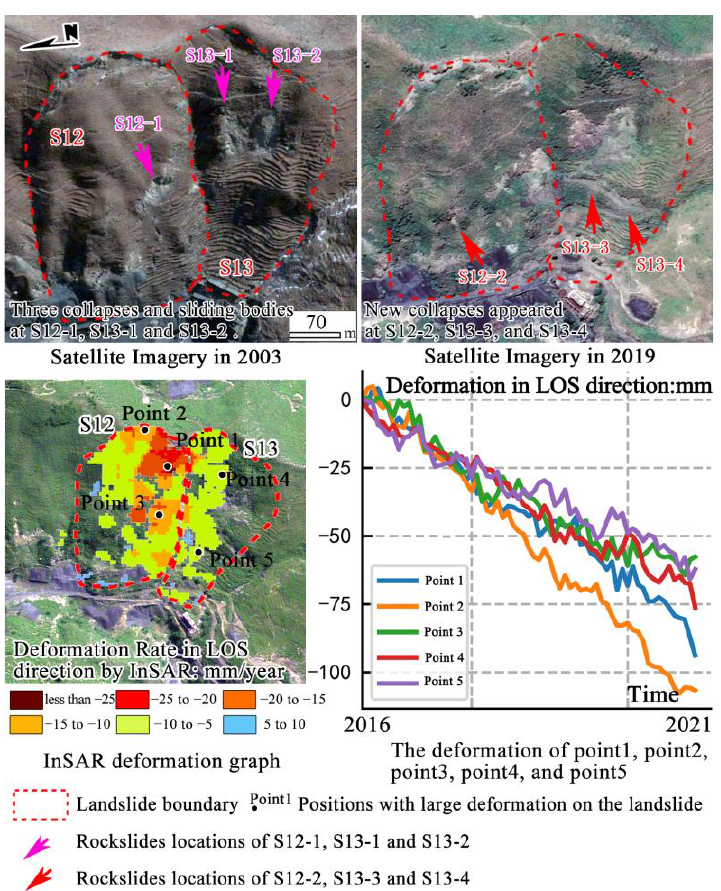
Figure 9. Optical images of landslide S12 and S13 acquired in 2003, and 2019 (the upper two panels). Deformation velocity of landslide S12 and S13 got by InSAR (left lower panel). The deformation in LOS direction of the five points during 2016–2021 are shown in the right lower panel.